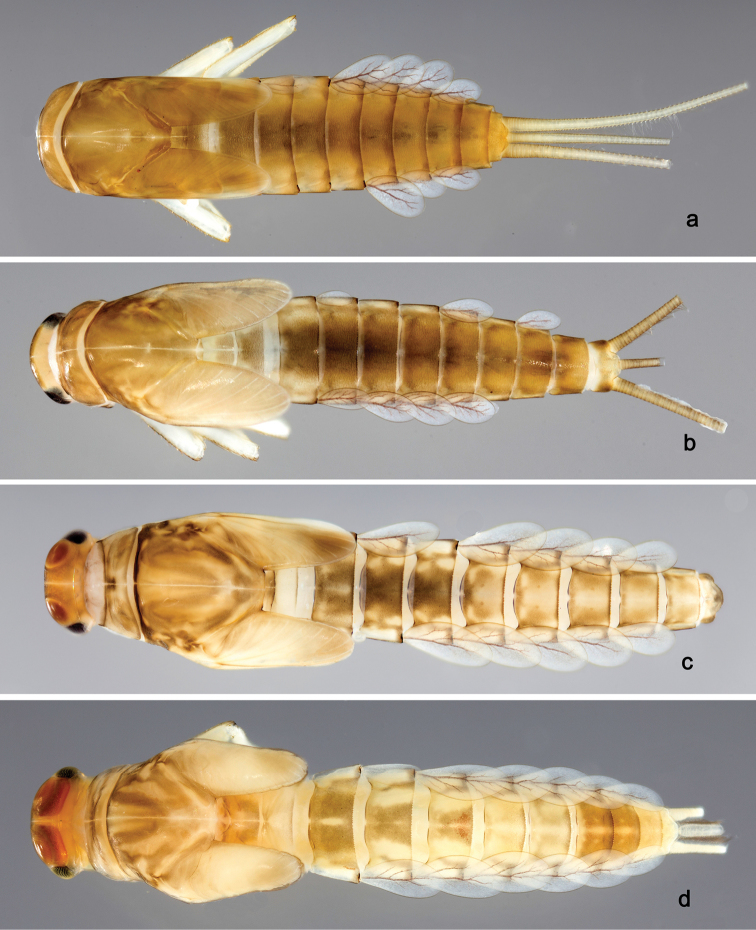
Habitus, larvae: aLabiobaetisrutschmannae sp. n., dorsal view, without head bLabiobaetisschwanderae sp. n., dorsal view cLabiobaetisaltus sp. n., dorsal view dLabiobaetisgindroi sp. n., dorsal view.